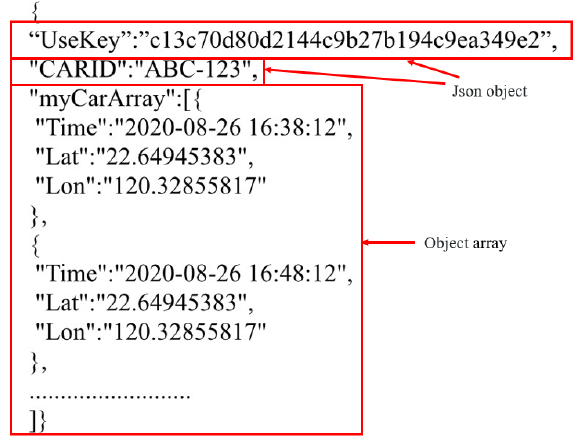
Figure 7. GPS data transfer format. Table 2. Background data system return code status table and actions.